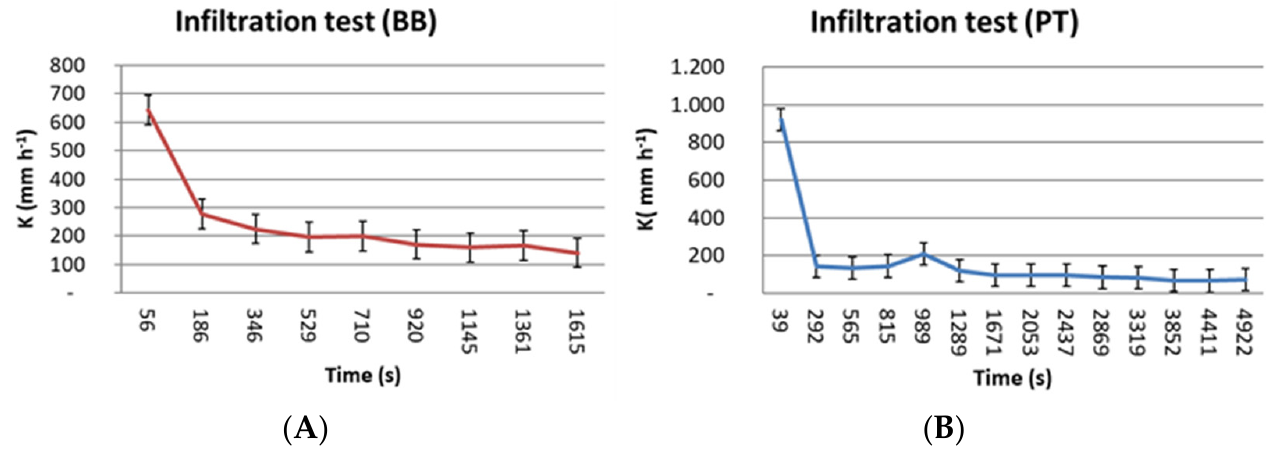
Figure 3. Infiltration test: Graphic ( A ), BS treatment; Graphic ( B) , PT treatment.